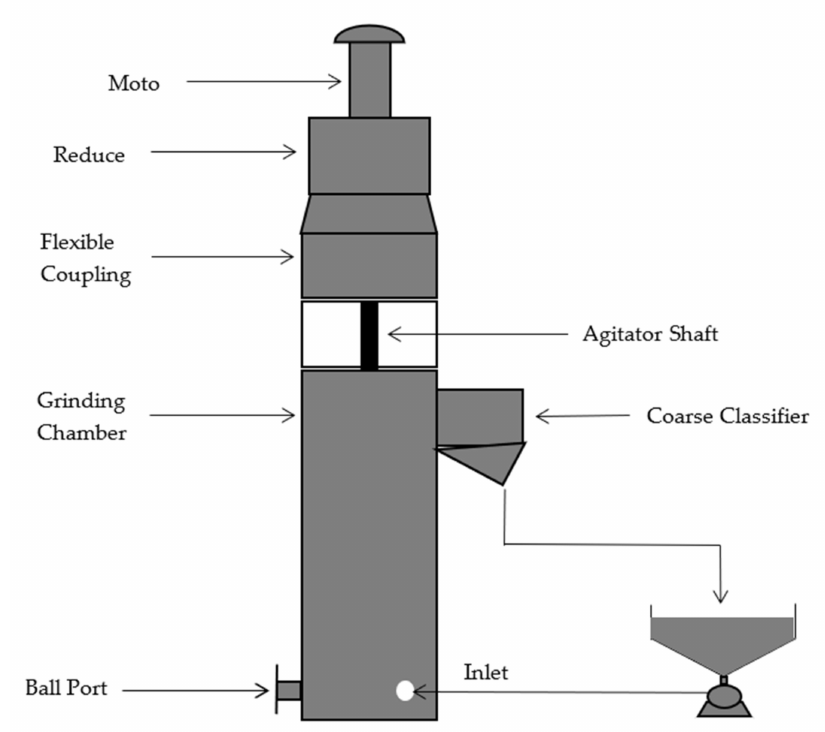
Figure 3. Illustration of the Kubota Tower mill rigged to operate as a batch mill.